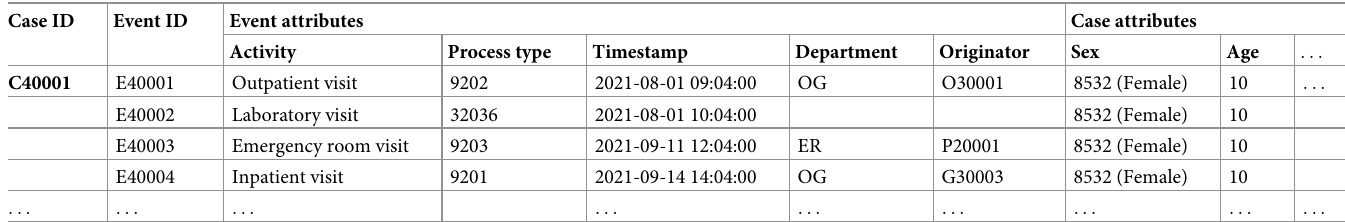
Table 5. An example log for patient